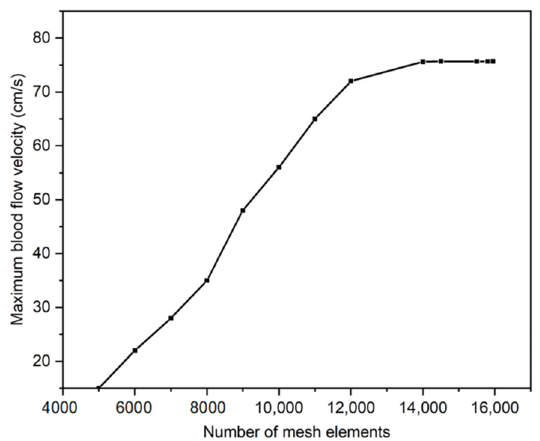
Figure 3. Mesh independence study: maximum blood flow velocity against the number of mesh elements in the domain.